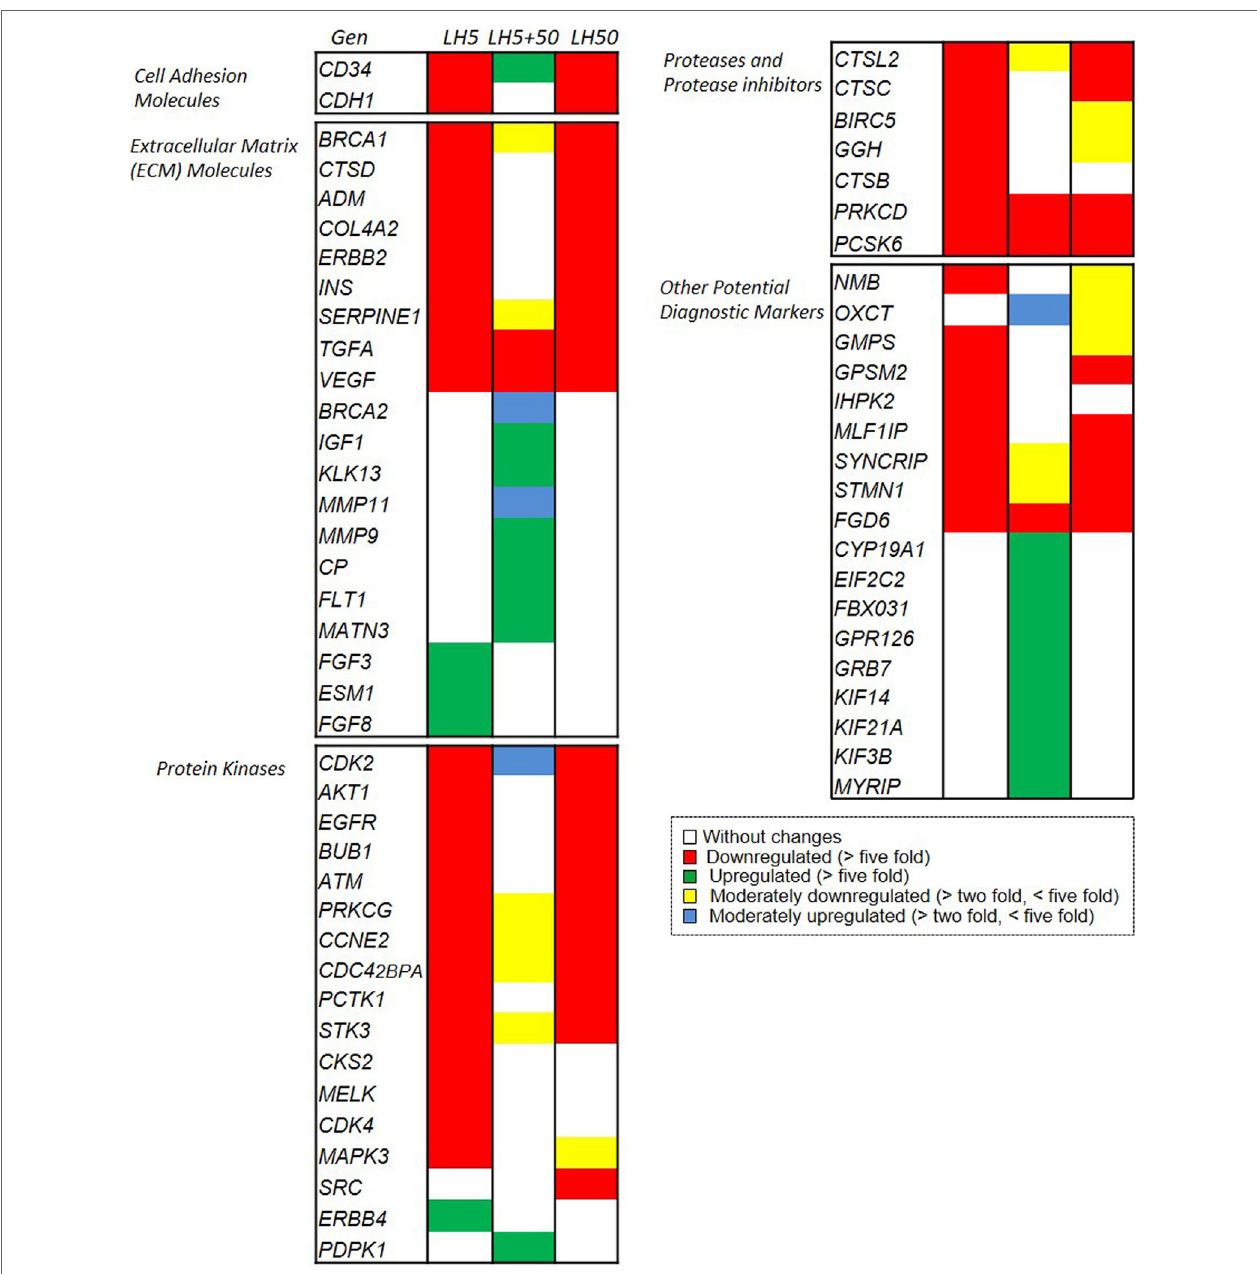
FigUre 7 | Microarray analysis of effects of LH on the expression of genes related to breast cancer biology. Different set of genes upregulated or downregulated, after LH treatment. Changes in gene expression are illustrated as fold increase/decrease. The cut-off induction determining expression was selected as an increase or decrease in expression of more than five times or more than two times as compared to untreated cells. Genes that suited the above criteria were considered to be upregulated or downregulated or to be moderately upregulated or downregulated, respectively, and they were arranged in different sets (Figures S1C–E in Supplementary